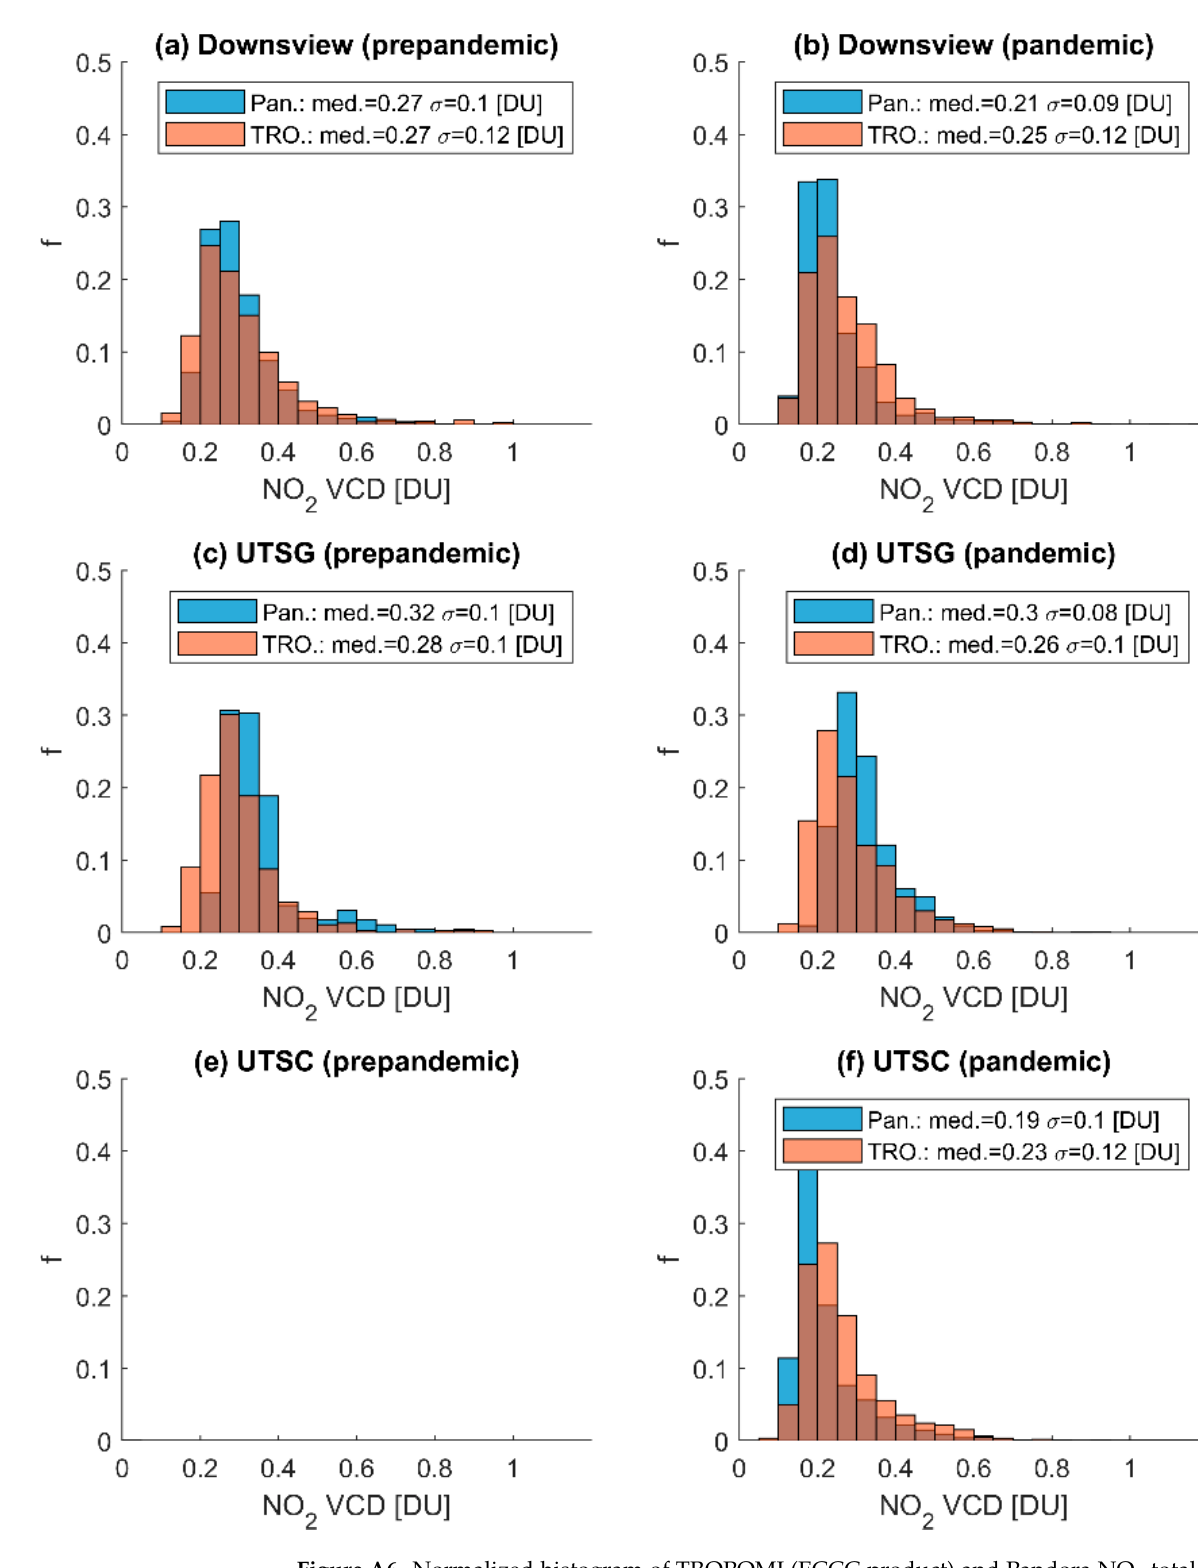
Figure A6. Normalized histogram of TROPOMI (ECCC product) and Pandora NO 2 total column (VCD) measurements at Downsview, UTSG, and UTSC, using data from before the pandemic ( a , c , e ) and since pandemic ( b , d , f ). The median and standard deviation of observations are shown in the legends. Pandora measurements taken within ± 1 h around the TROPOMI overpass time were used (observations from 15 March to 15 September for each year).